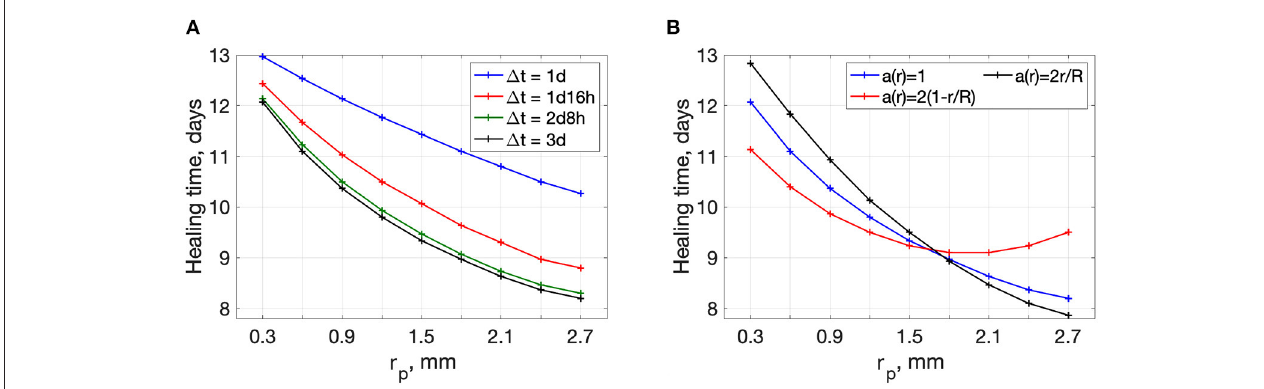
FIGURE 6 | Wound healing time dependence on the actuator position r p . (A) plots for different treatment durations 1 t , t 0 = 0 h (B) plots for different initial distributions of debris in the wound, t 0 = 0 h 1 t = 3days.